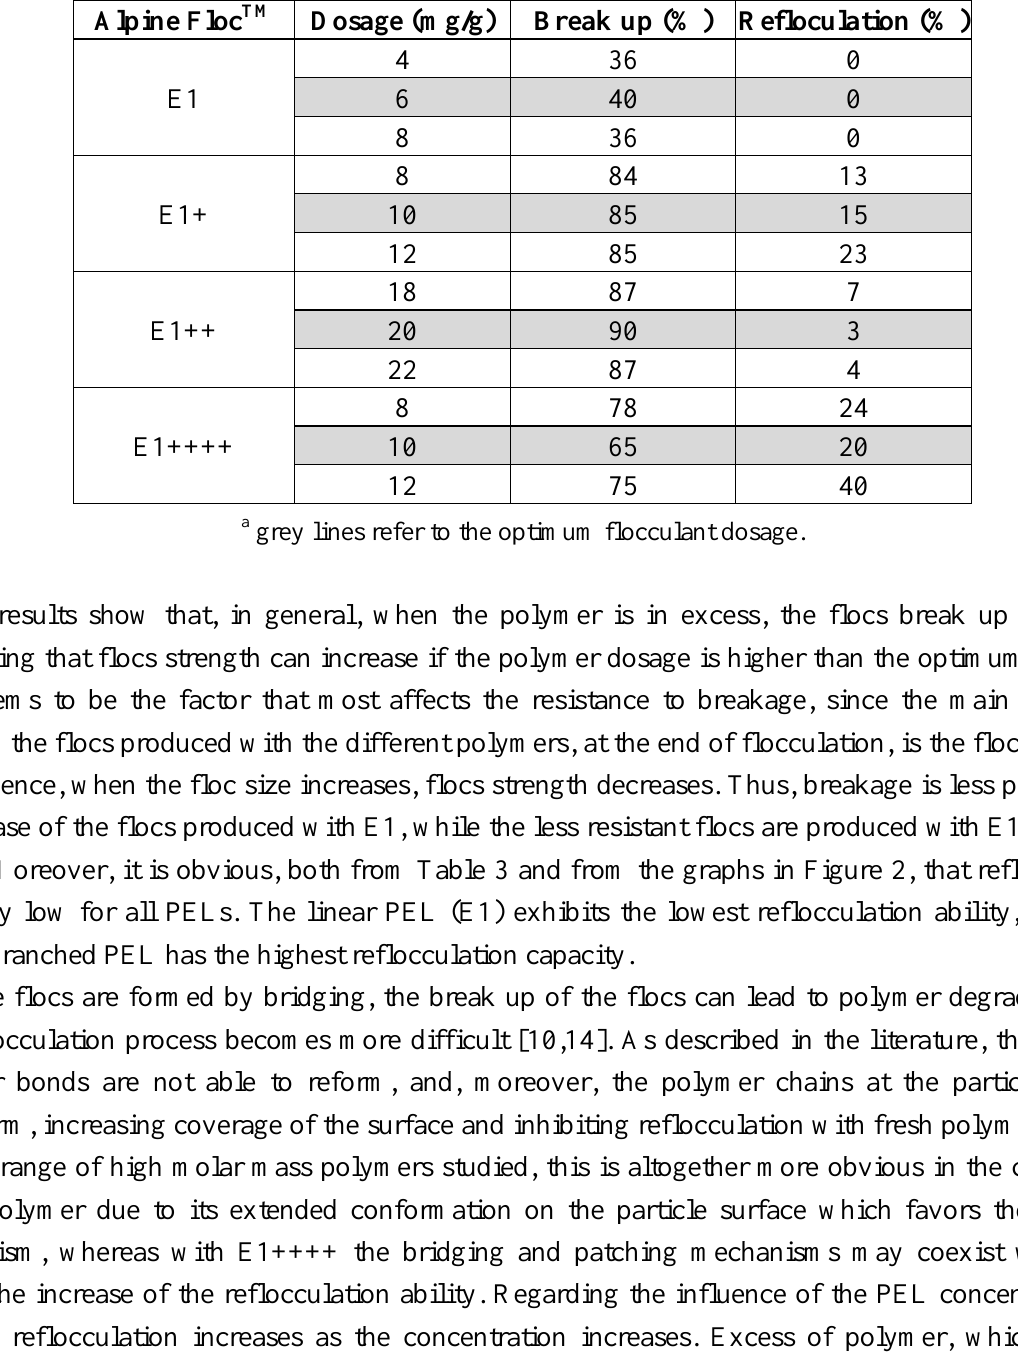
Table 3. Break up and refloculation percentages for the different PELs a